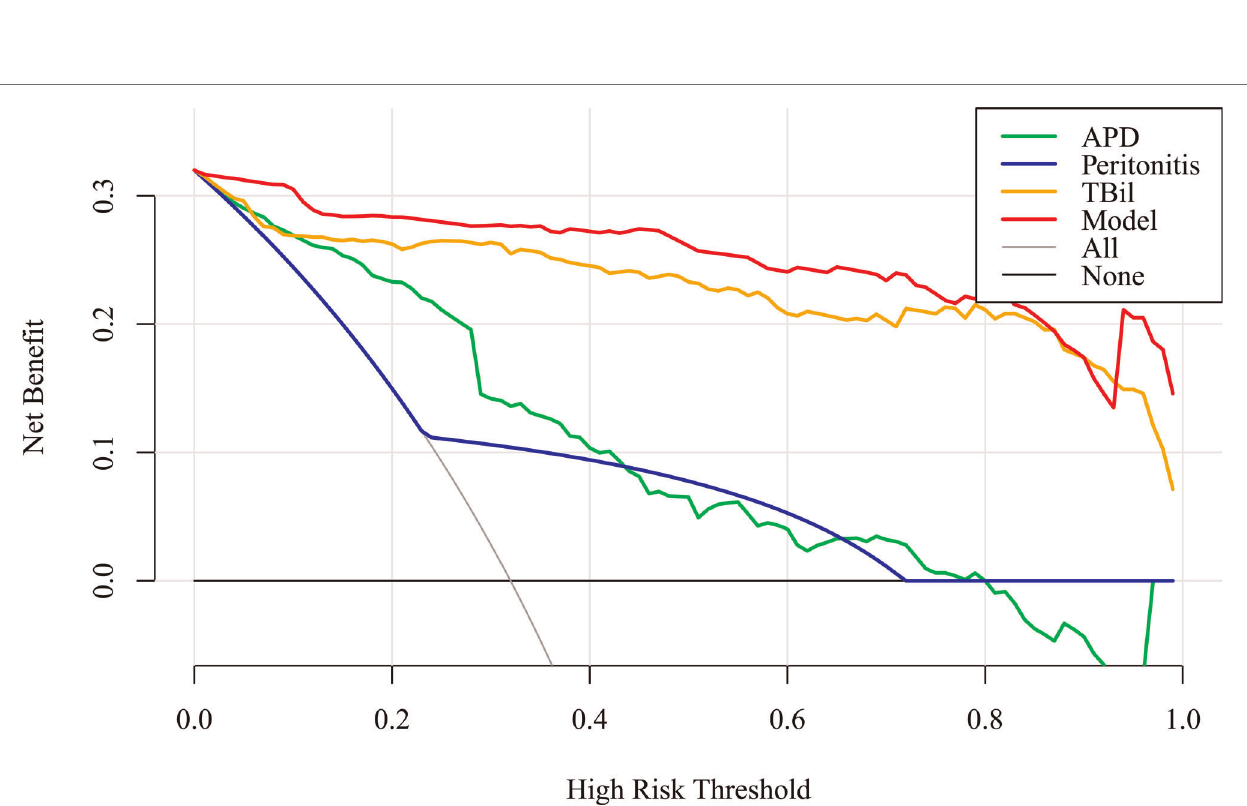
FIGURE 4 | Model calibration diagram for predicting complicated appendicitis in the elderly.